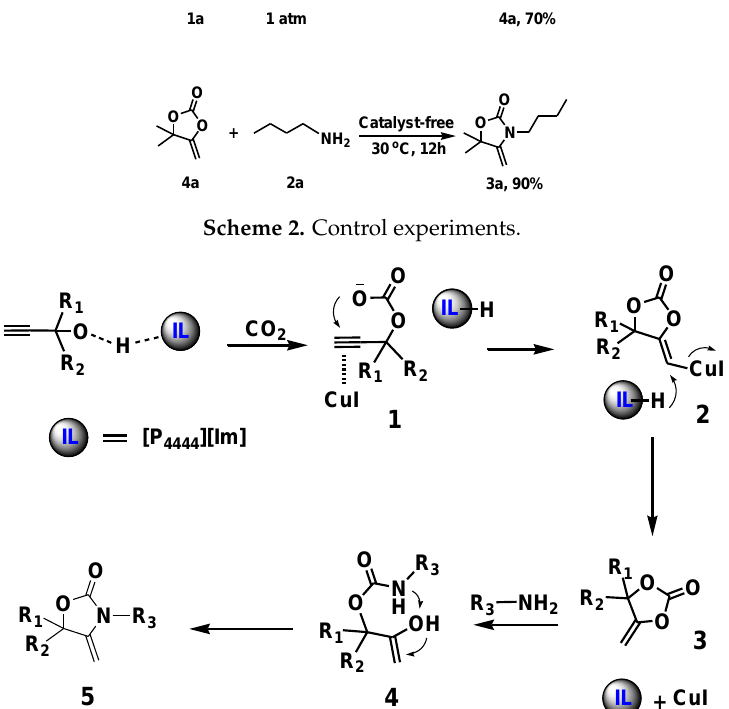
Molecules 2019 , 24 , 1241 6 of 10 Figure 4. 13 C-NMR spectra of propargylic alcohol, n -BuNH 2 with and without CuI/[P 4444 ][Im] catalyst.